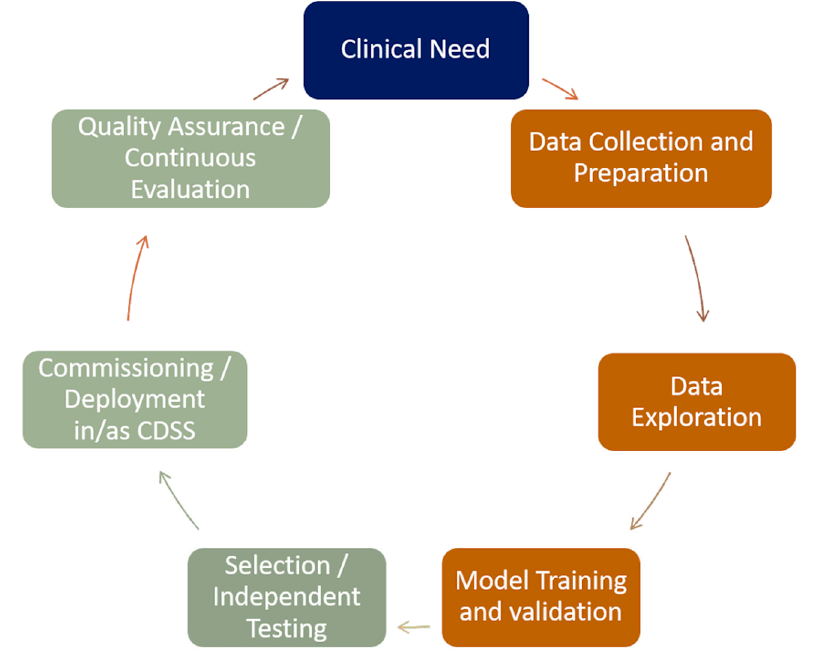
Figure 4. Overview of the interconnections among the developments of an iCCDS and the traditional software lifecycle schema.